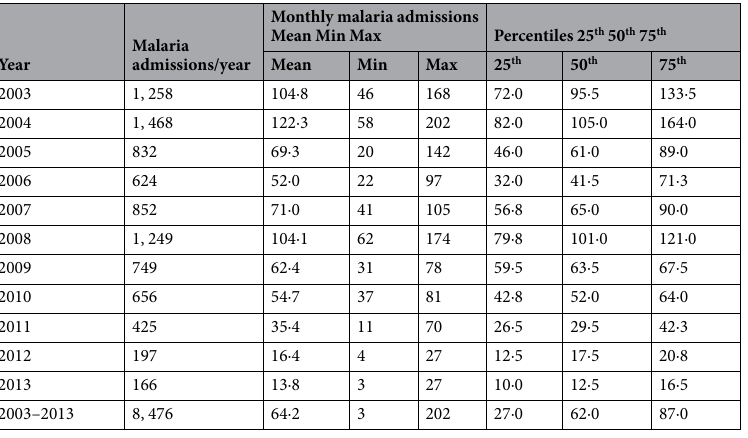
Table 1. Distribution of pediatric malaria admissions by year and overall at Siaya District hospital, Karemo division, Siaya county, Western Kenya,